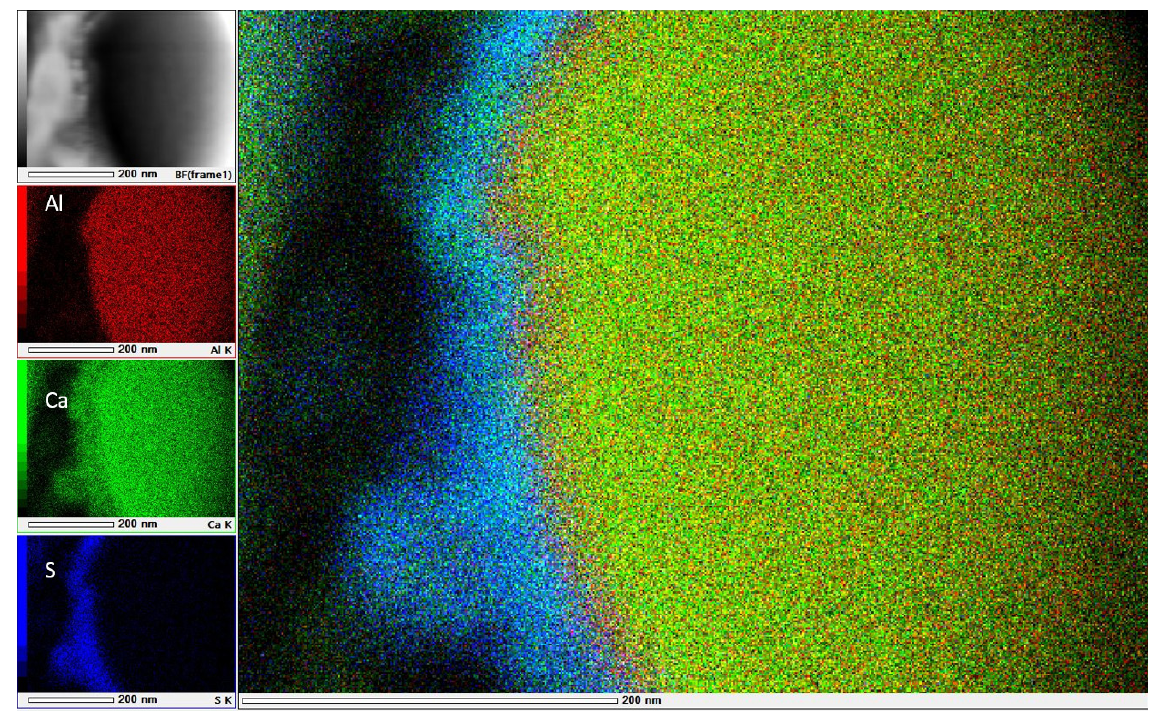
Figure 6. TEM-EDS element overlay map showing individual (left column) and combined maps for Al, Ca, and S. Scale = 200 nm. After Hood et al. [15].